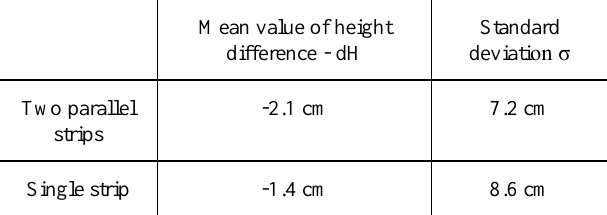
Table 5. Values for height differences between the DTM from